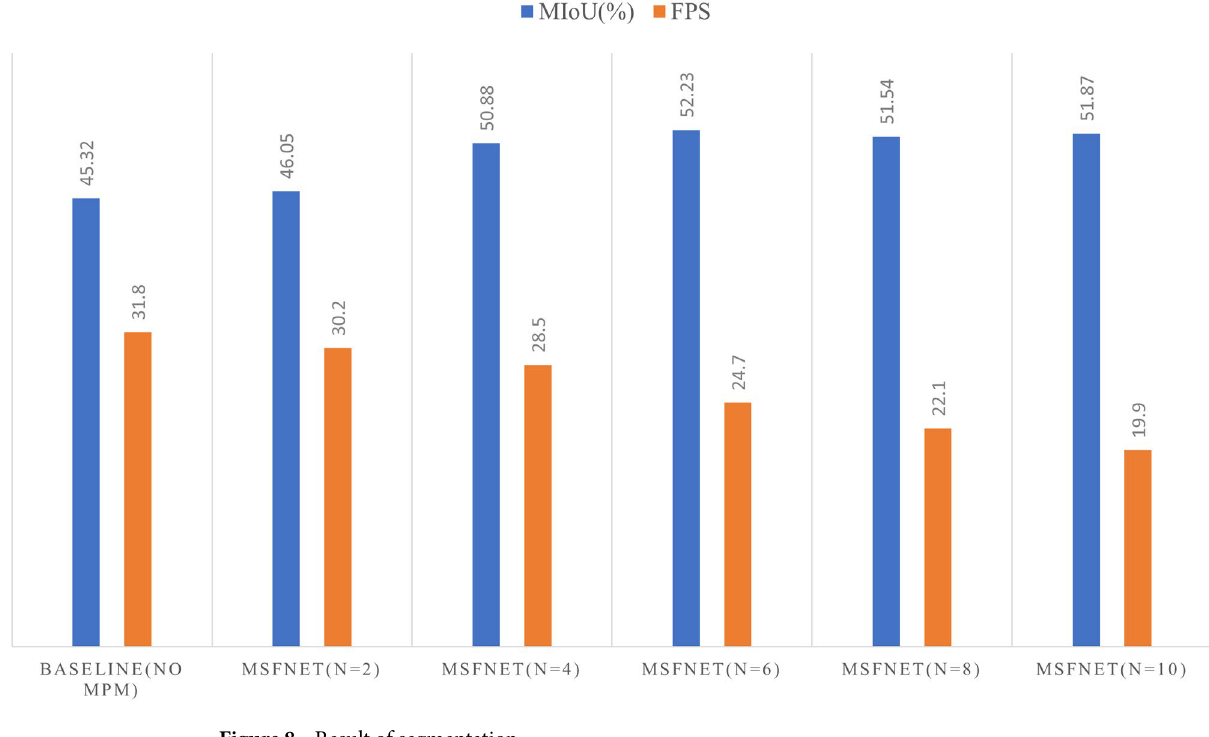
Figure 8. Result of segmentation.